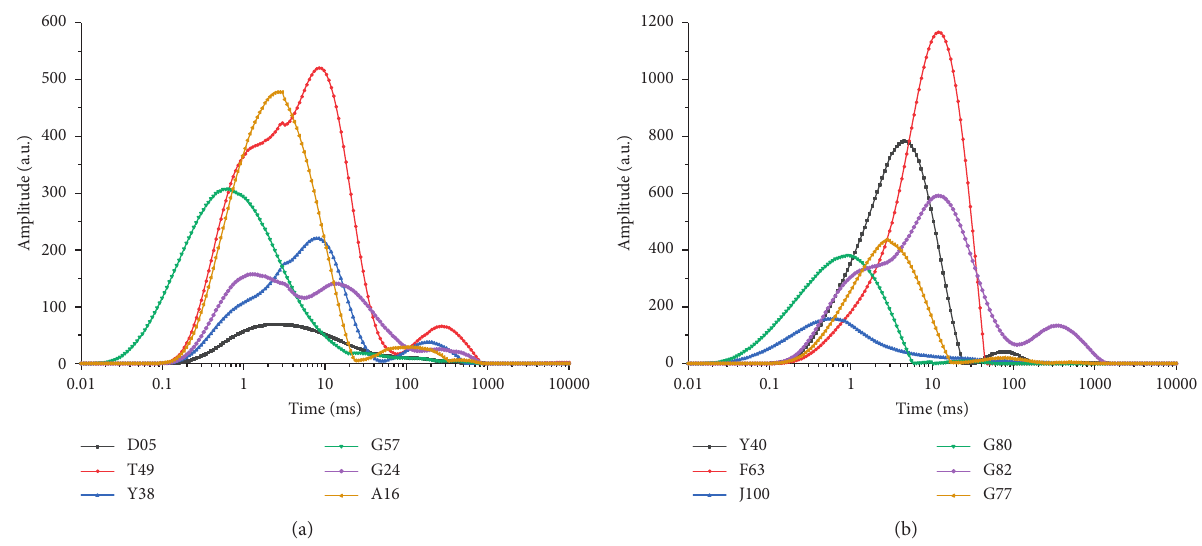
Figure 4: NMR T 2 spectra motivated from n -C 12 in effective pores of oil shale. UCQ, Upper Cretaceous Qingshankou (a); UCN, Upper Cretaceous Nenjiang (b).